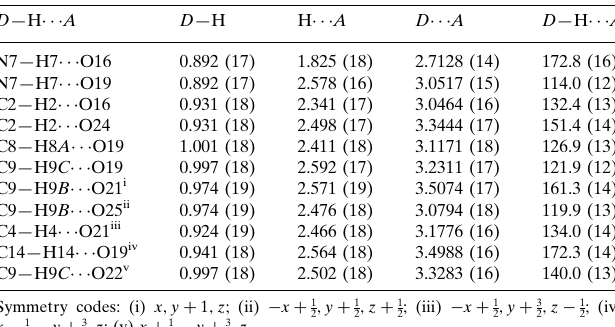
Hydrogen-bond geometry (A˚ , (cid:4)